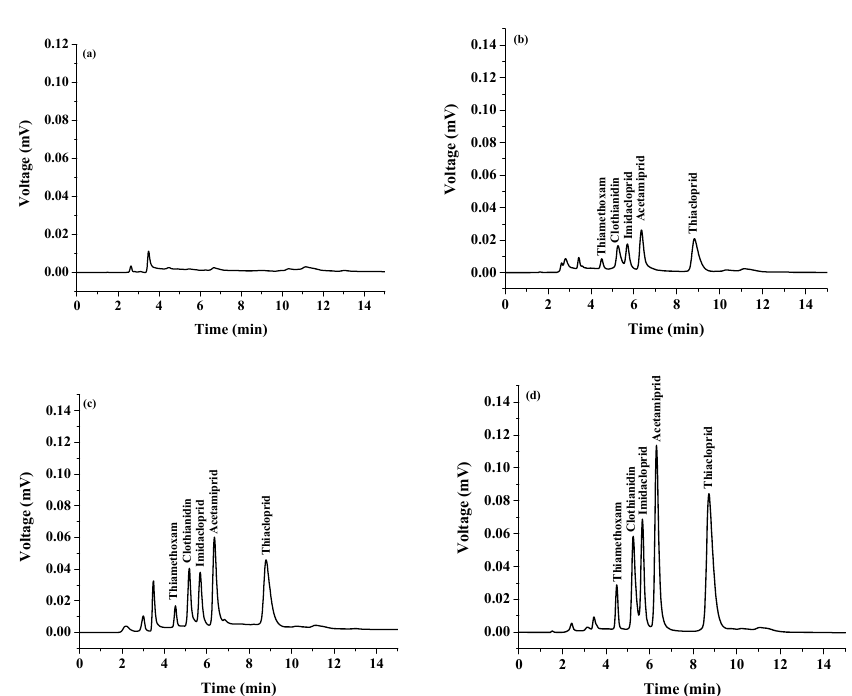
Figure 6. Typical chromatograms of ( a ) water sample, ( b ) water sample spiked at 0.025 µ g mL − 1 of each insecticide, ( c ) water sample spiked at 0.050 µ g mL − 1 of each insecticide, and ( d ) water sample spiked at 0.100 µ g mL − 1 of each insecticide, extracted by the proposed extraction method and analysis by HPLC.